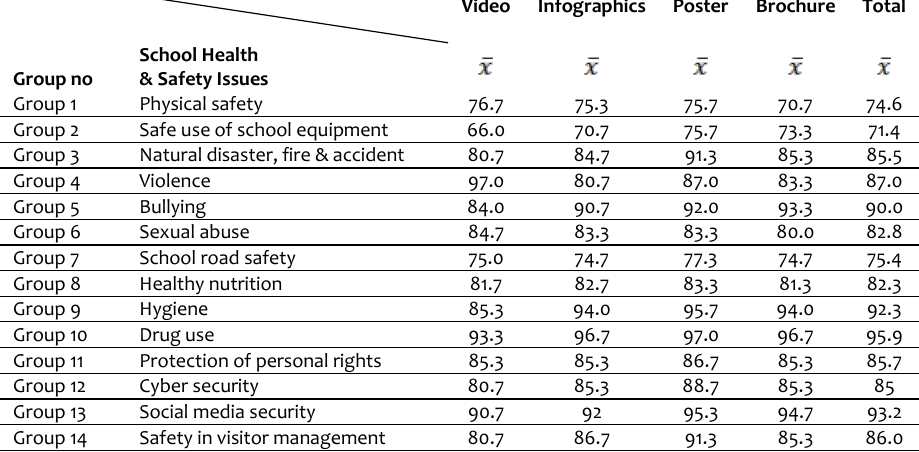
Table 4. Mean scores for group